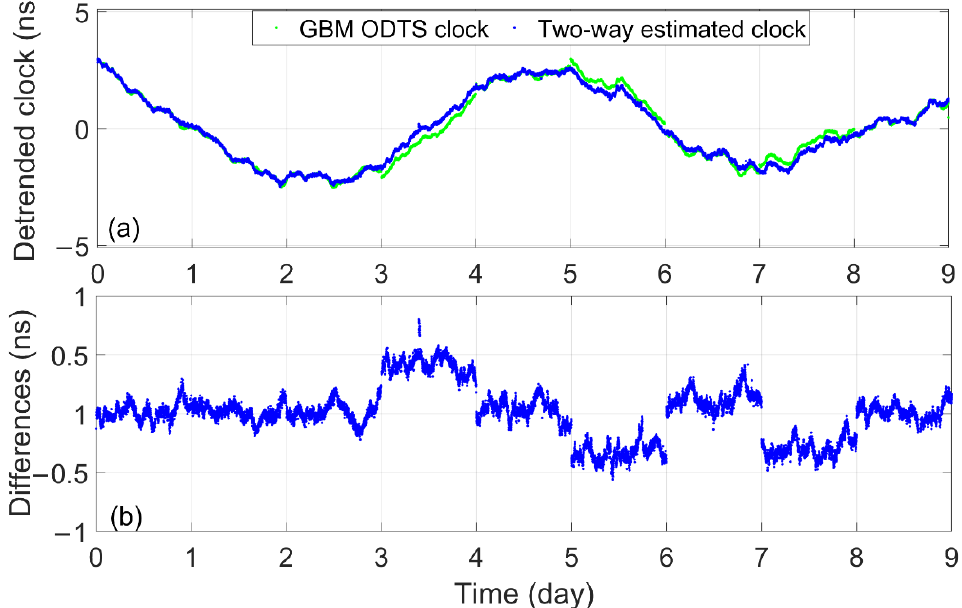
Figure 10. 9-day Satellite clock offset differences between the Ka-band inter-satellite estimated clock offsets and GBM products. Wherein, ( a ) describes the two kinds of clock offsets after deducting the same trend. ( b ) describes their differences. The reason why “hop” exist in the bottom figure is that the day-boundary discontinuities exist in the ODTS clock offsets (since 19 May 2022).